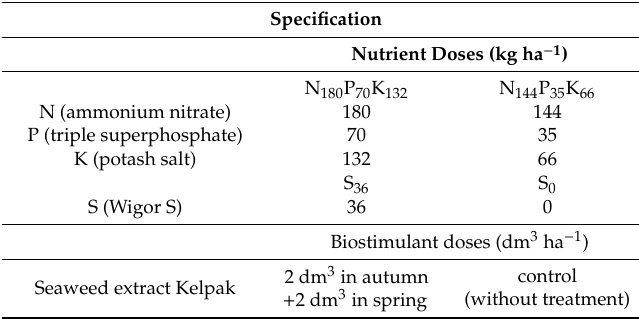
Table 1. Experimental treatments: NPK fertilization—nitrogen (N), phosphorus (P), and potassium (K); fertilization with sulphfur (S); biostimulant